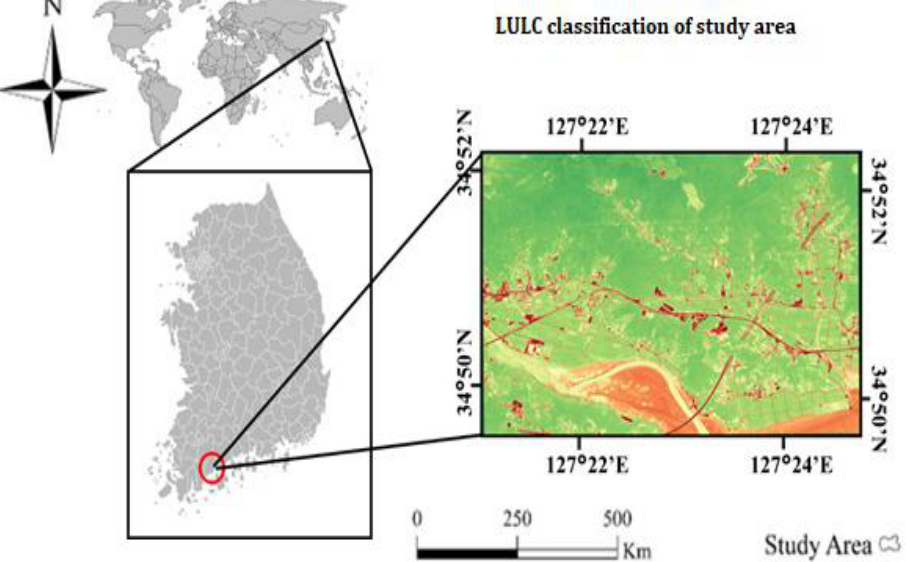
Figure 1. The location of the study area inside the southern part of Beolgyo, Boseong County, South Korea.